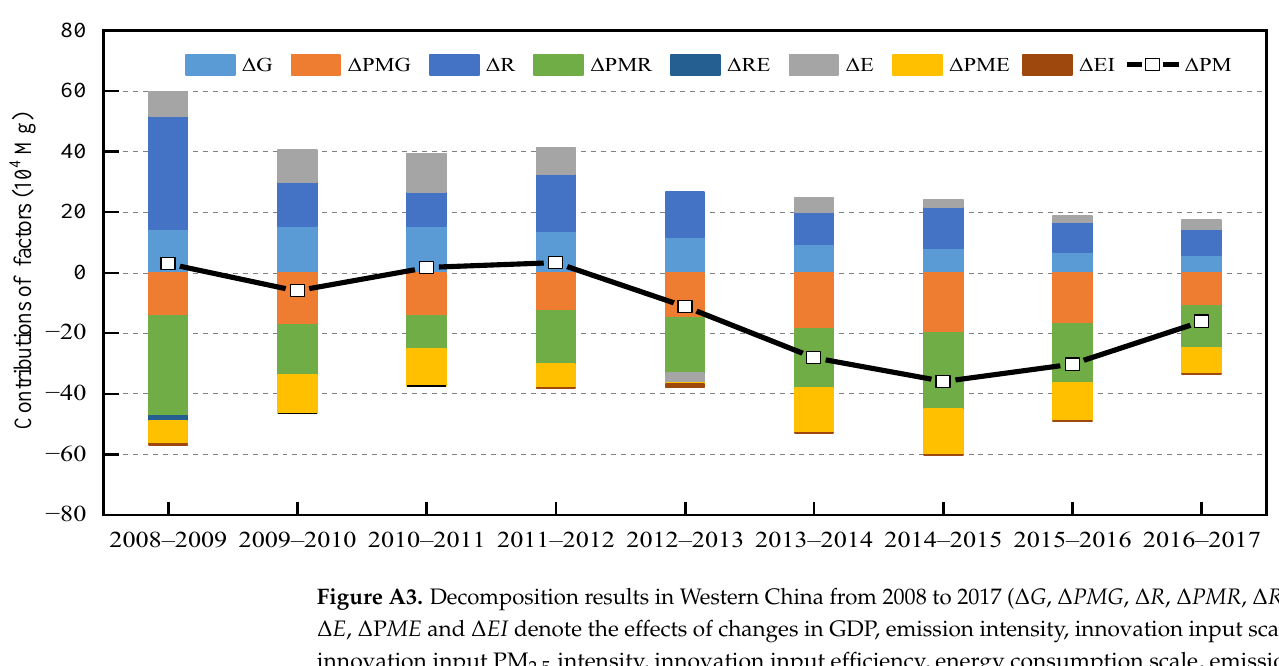
Figure A2. Decomposition results in Central China from 2008 to 2017 ( Δ G , Δ PMG , Δ R , Δ PMR , Δ RE , Δ E , Δ PME and Δ EI denote the effects of changes in GDP, emission intensity, innovation input scale, innovation input PM 2.5 intensity, innovation input efficiency, energy consumption scale, emission coefficient, and energy intensity on the changes in PM 2.5 emissions, respec tively. Δ PM indicates the changes in PM 2.5 emissions).